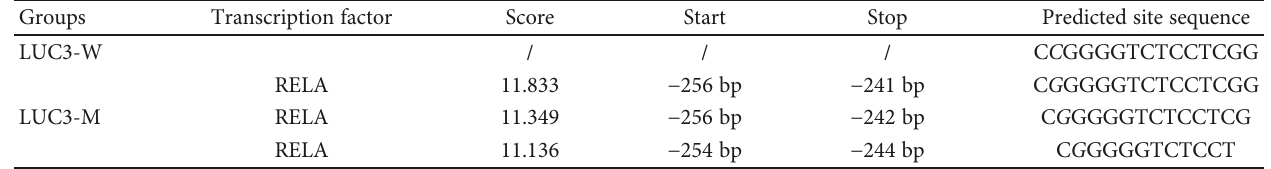
Table 3: Prediction of the binding of the transcription factor to the promoter region of the TRPC6 gene with or without the − 254C > G SNP. Groups